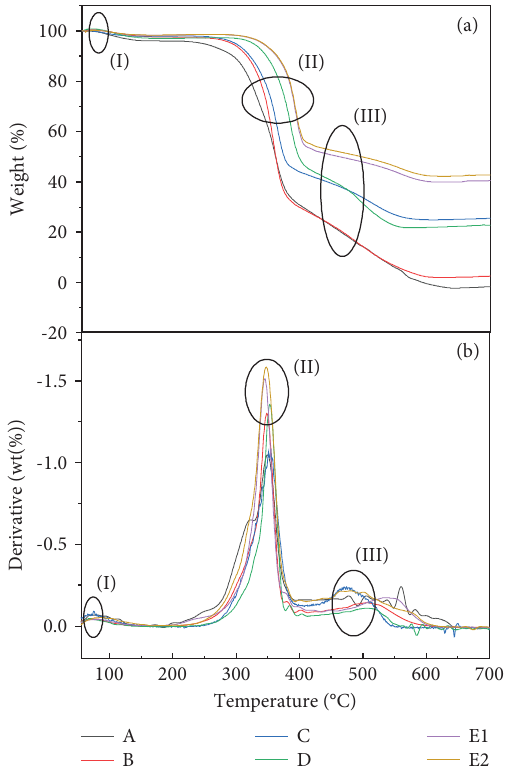
Figure 8: (a) (e thermogravimetric analysis and (b) the differ- ential thermal analysis curves of cellulose extracted from the dif- ferent methods.